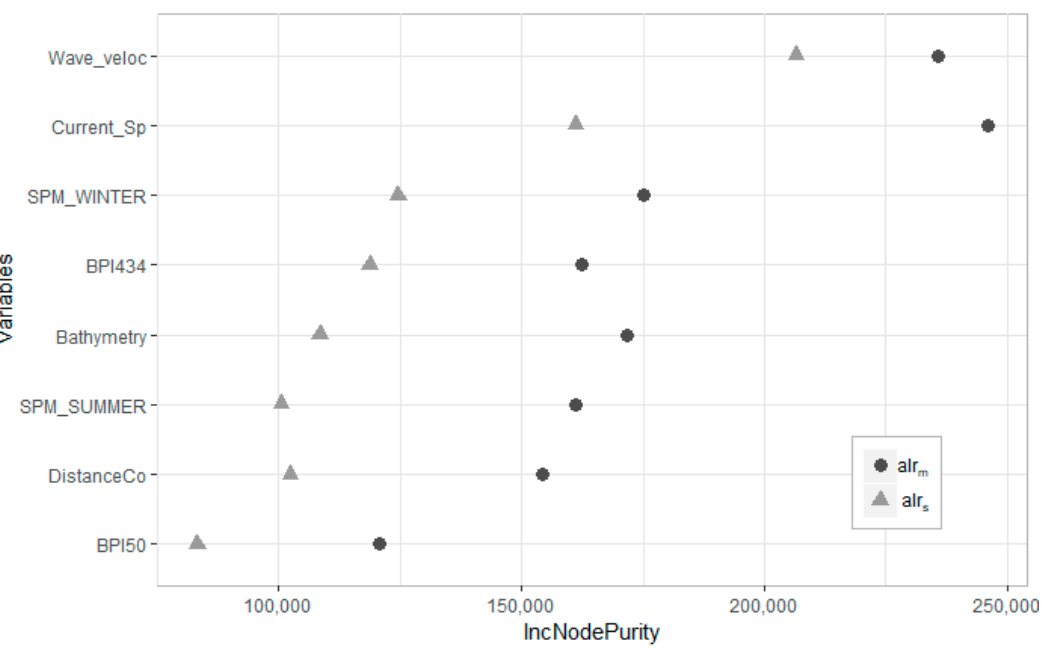
Figure 2. Feature importance scores. The importance of predictor variables for both modelled log-ratios indicated by the random forest algorithm. The x-axis indicates the average decrease in node sum of squares when variable is used.